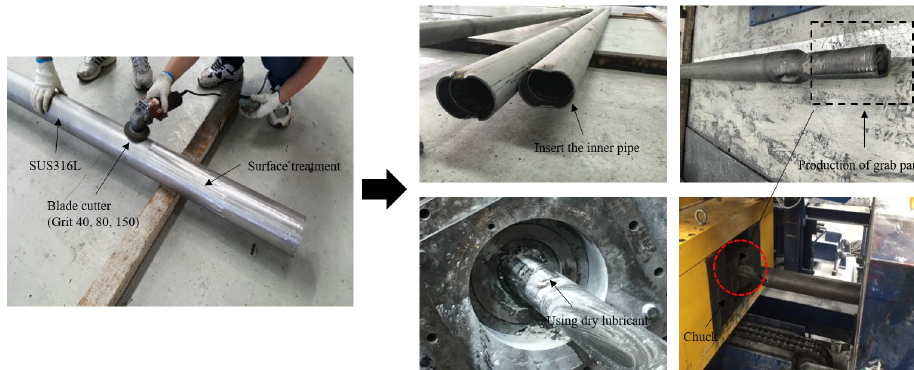
Figure 8. Process of double-layered pipe using drawing.